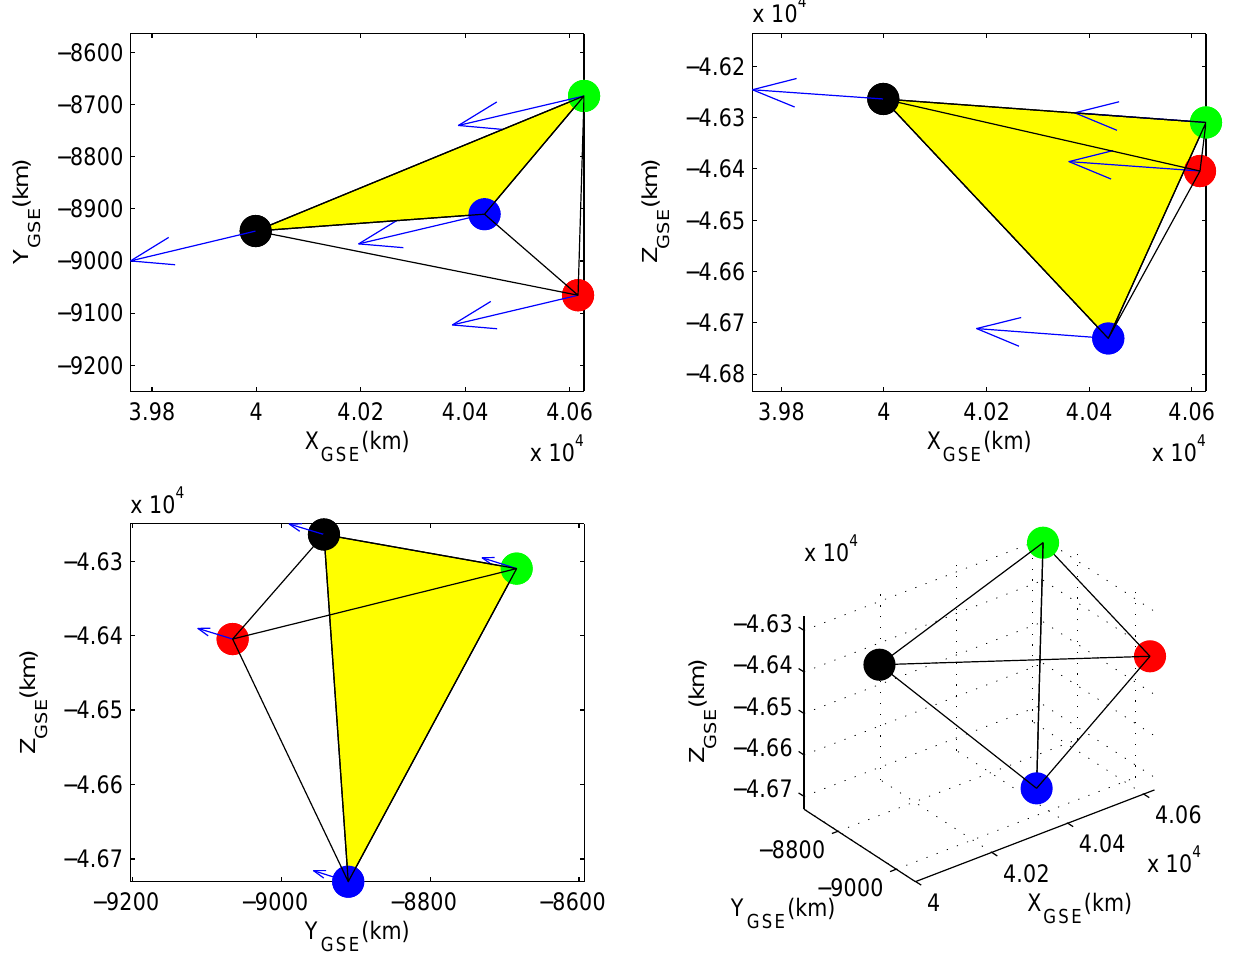
Fig. 2. The spacecraft configuration at 20:00UT on 13 February 2001. The four panels show the tetrahedron projected onto the GSE x–y, x–z and y–z planes, and a three-dimensional representation of the spacecraft formation. The four Cluster spacecraft are denoted by the coloured dots. The blue arrows correspond to the direction of the spacecraft motion projected onto the appropriate plane. Their length is proportional to the velocity projected onto each